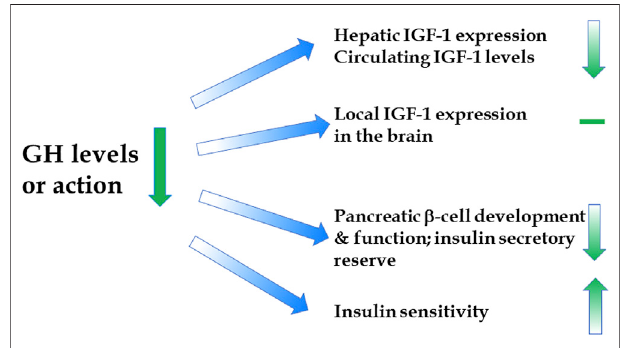
FIGURE 1 | Impact of reduced GH signaling on the levels and actions of IGF-1 and insulin.